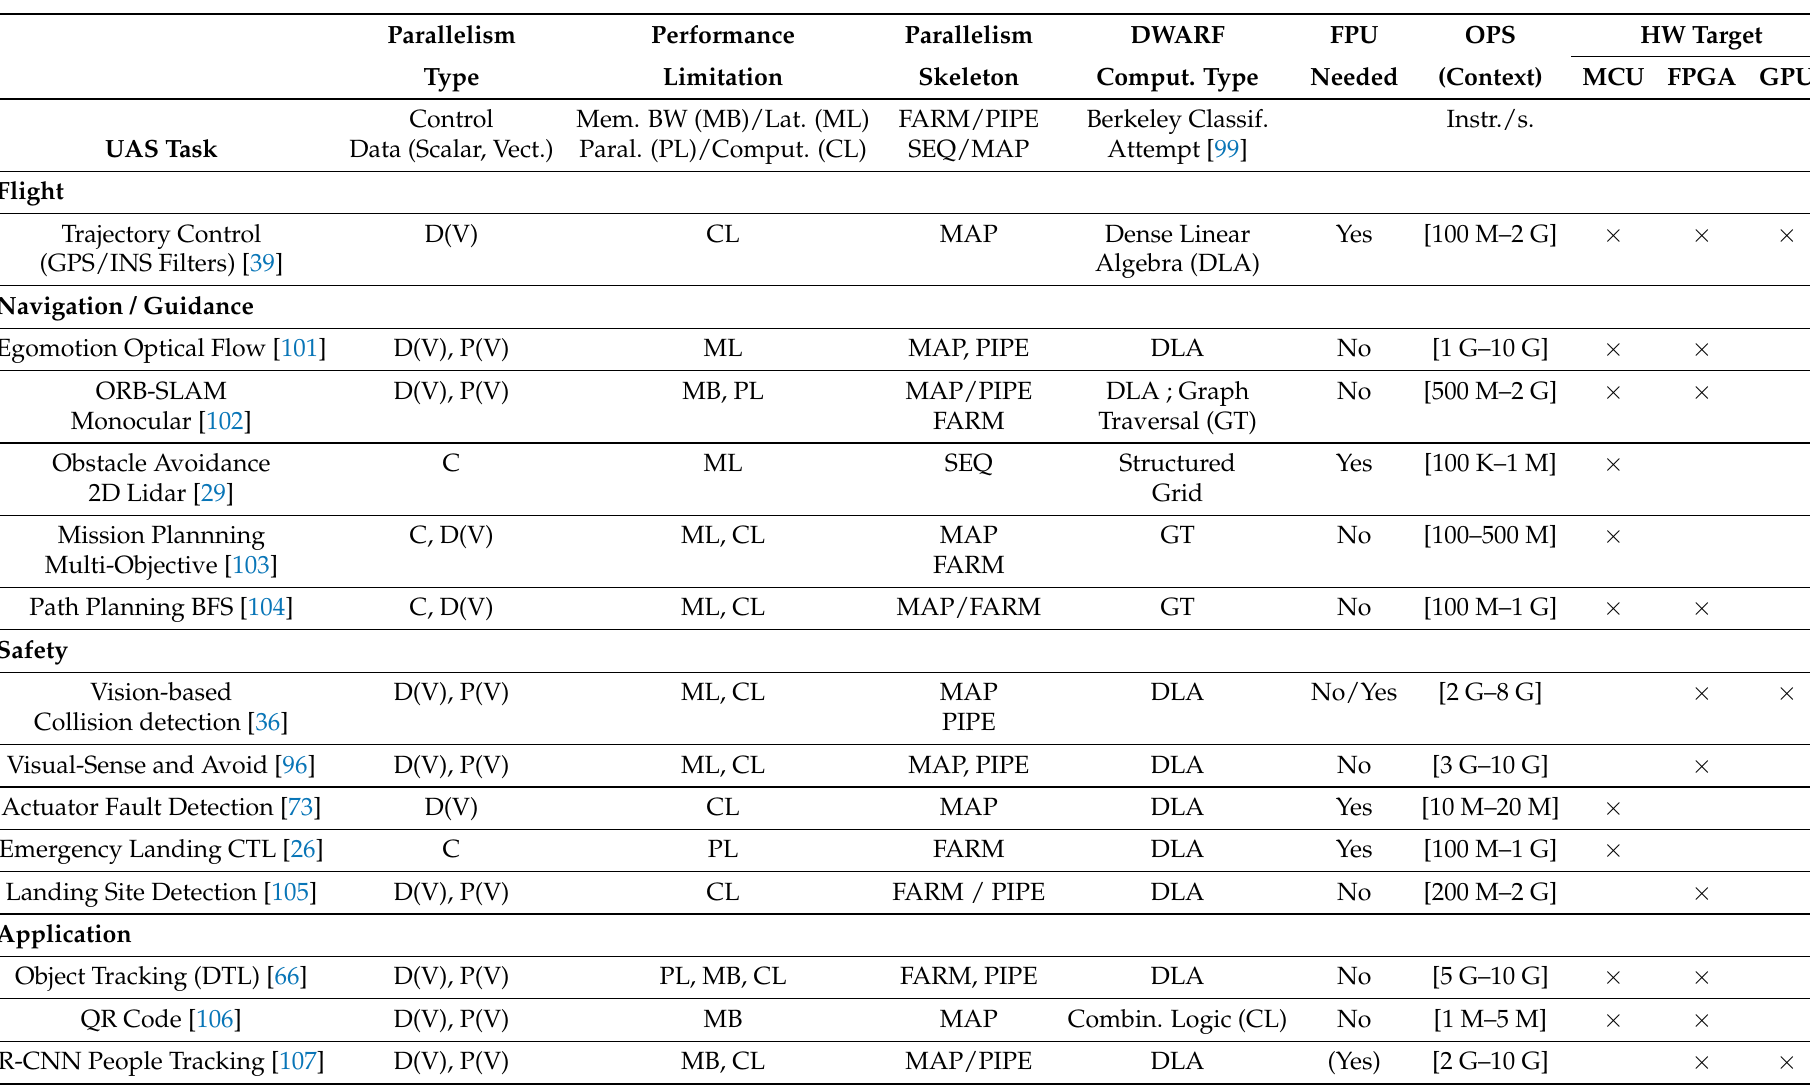
Table 5. UAS tasks for the case study: computation metrics are based on representative references and published